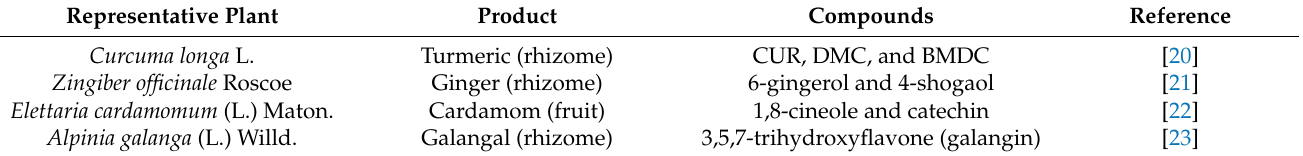
Table 1. Summary of products and compounds from representative plant species from